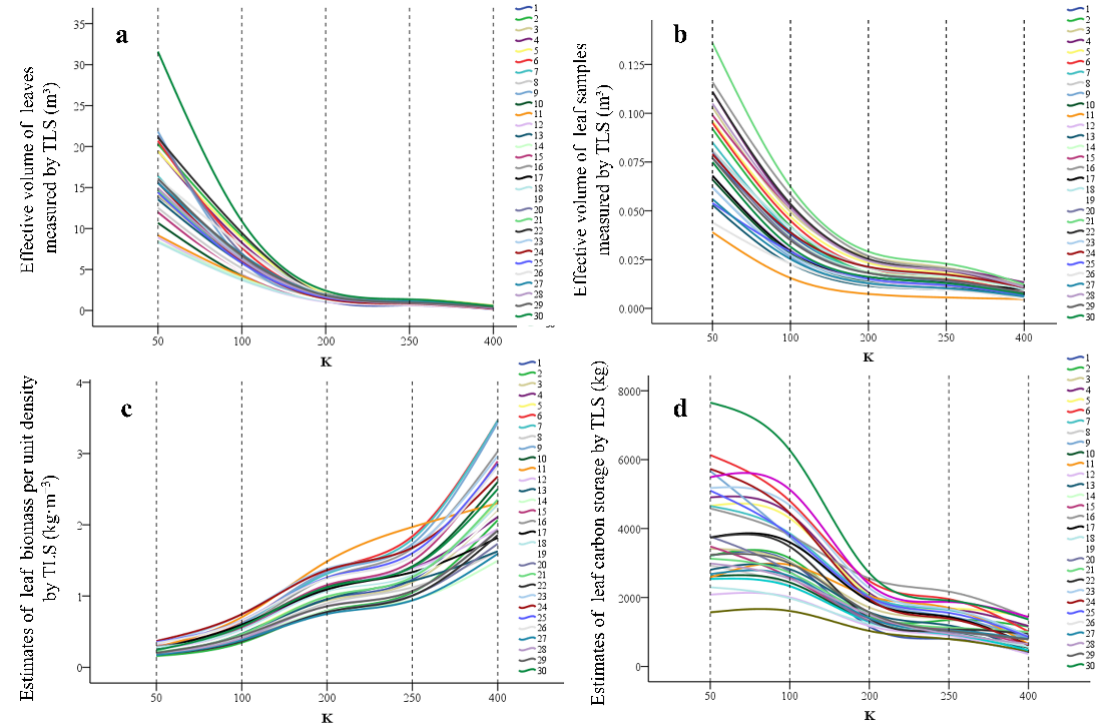
Figure 7. The K represents the ratio of crown size to the pixel side length. ( a ) Effective volume of leaves, ( b ) effective volume of leaf samples, ( c ) biomass per unit density of leaves, and ( d ) carbon stock in canopy leaves based on different image size measurements.